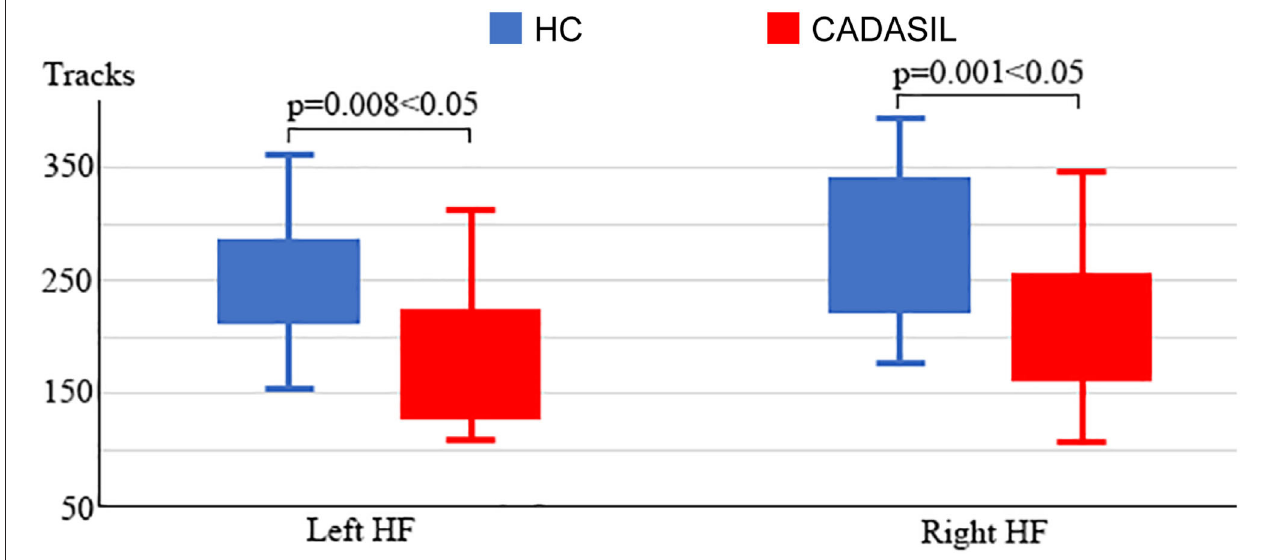
FIGURE 4 | Analysis of fiber tracks in the DMN in CADASIL and control groups. Patients with CADASIL had decreased fiber tracks in the bilateral HF. DMN, default mode network; CADASIL, cerebral autosomal dominant arteriopathy with subcortical infarcts and leukoencephalopathy; HF, hippocampal formation; HC, healthy control.